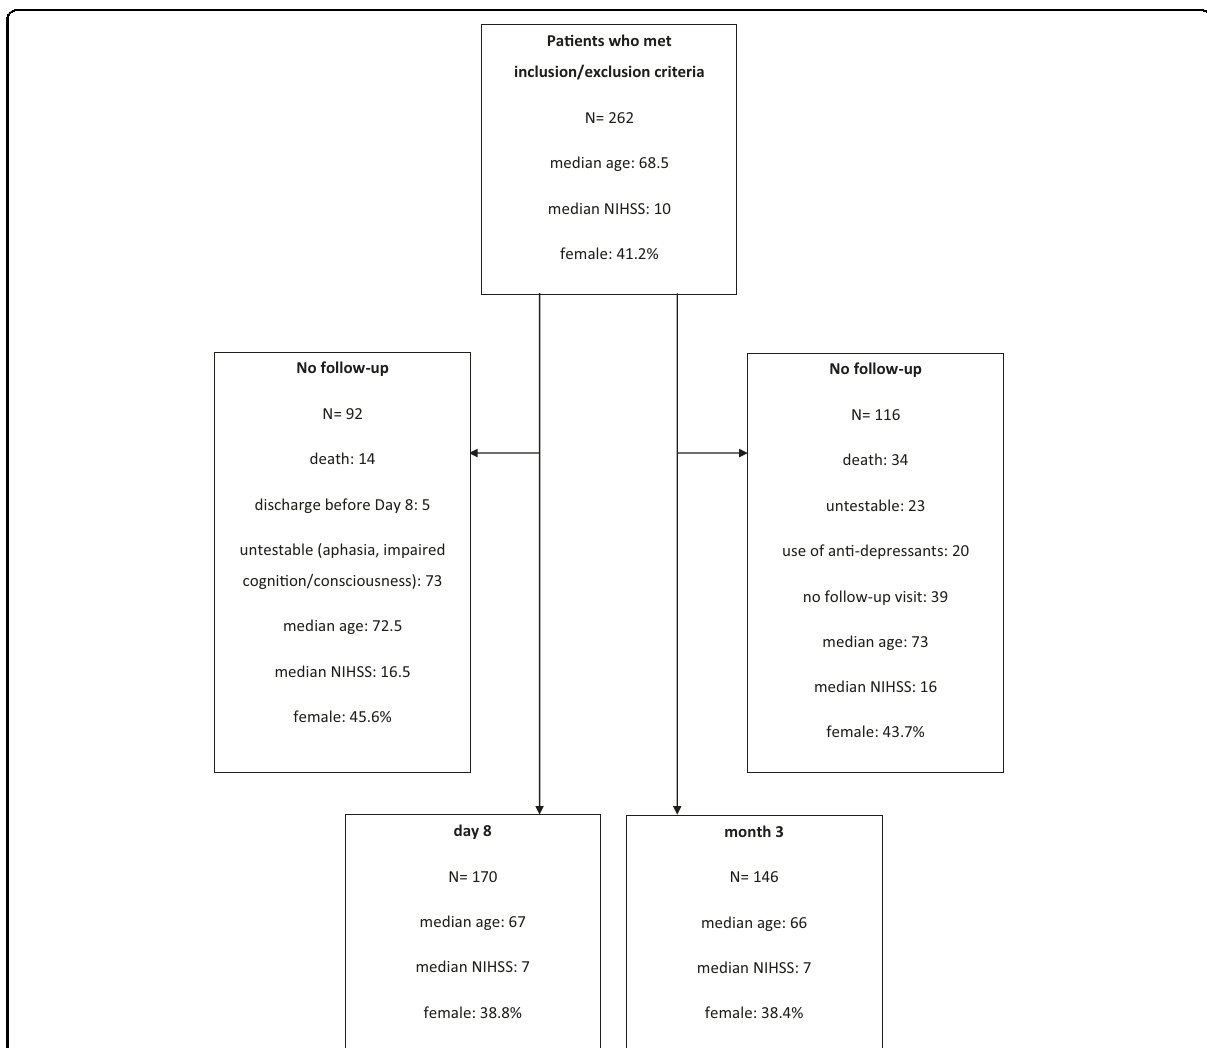
Fig. 1 Excluded and included patients. NIHSS: National Institute of Health Stroke Scale. Flow chart showing the numbers of patients included in the